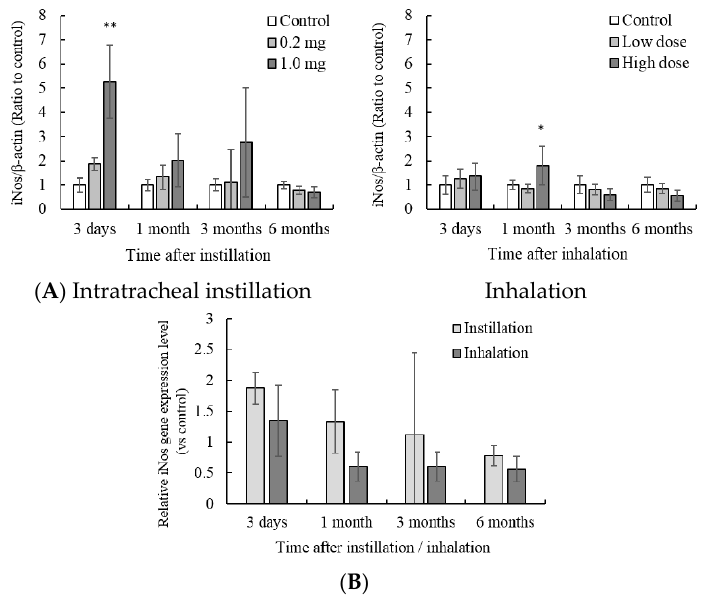
Figure 5. Influence of NiO nanoparticle exposure on the gene expression of iNos in the lung. ( A ) iNos gene expression in the lung after intratracheal instillation and inhalation. The gene expression of iNos was determined by real-time PCR. Values are mean ± SE ( n = 5). Significant differences versus control group are indicated in the figure (ANOVA, Dunnet). ** p < 0.01, * p < 0.05; ( B ) Comparison of 0.2 mg intratracheal instillation and high dose inhalation.